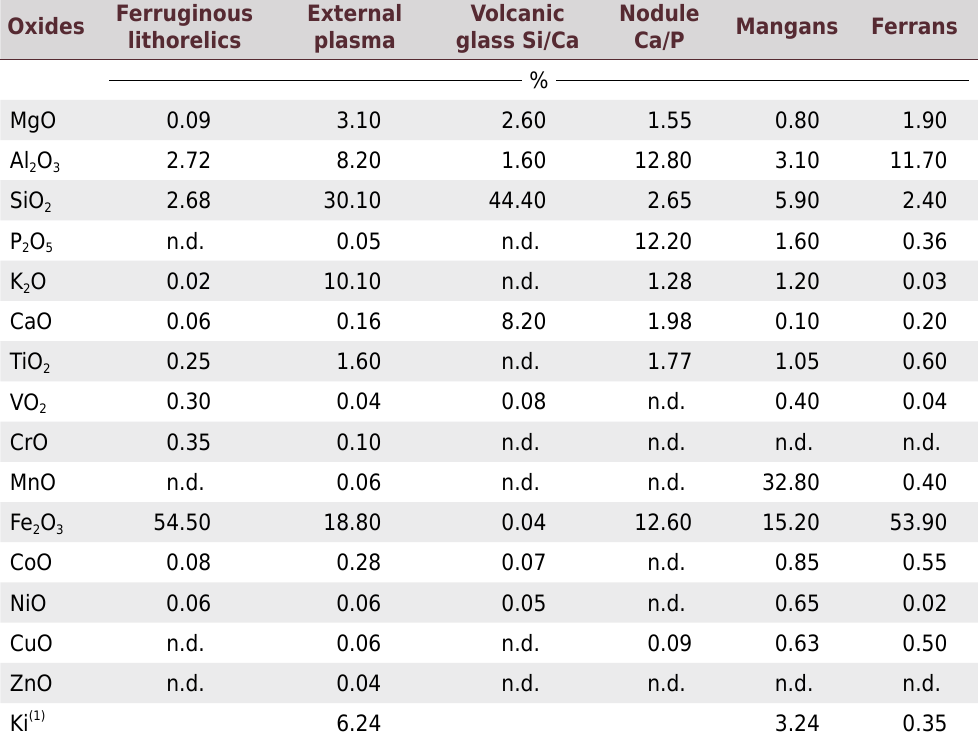
Table 7. SEM-WDS microchemical analysis of selected pedofeatures of the Bi horizon in the P 6 - Eutric Chromic Petroplintic Leptic Cambisol (Clayic, Humic); Coromandel topolithosequence Ferruginous Oxides